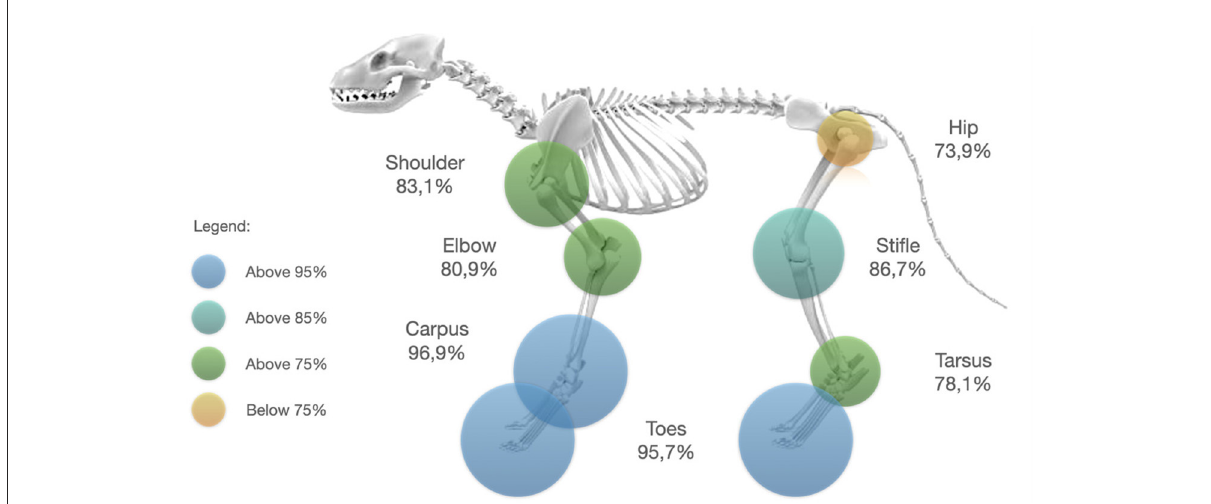
FIGURE3 Percentage of true positive flexion test result exposed by joint area. The circles represent the proportion of true positives recorded for the considered area. The colors represent gradually the true positive percentage result reached for each joint area.